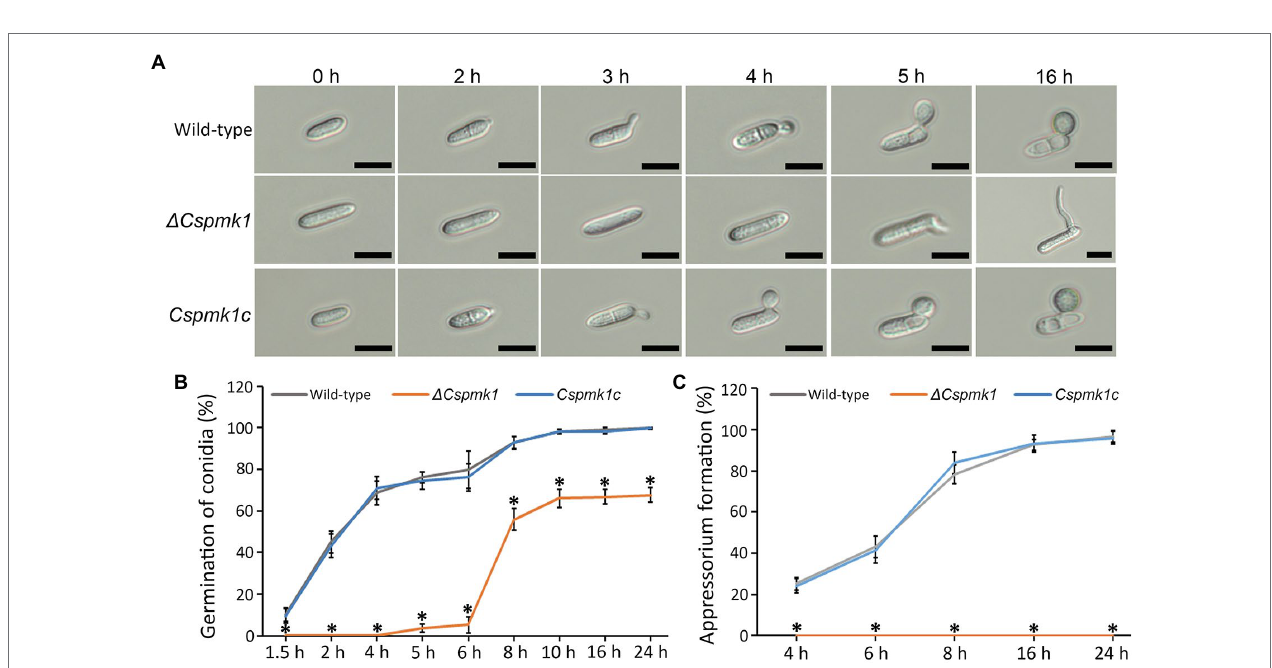
FIGURE 3 | CsPMK1 is essential for conidial germination and appressorium formation. (A) Photographs of conidial germination and appressorium formation. Conidial suspensions (5 × 10 4 ml − 1 ) harvested from 7-day-old oatmeal agar (OMA) were dropped into the hydrophobic surface of coverslips and incubated at 25 ° C. Scale bar, 10 μ m. (B,C) Quantitative measurement of conidial germination (B) and appressorium formation (C) . Conidial suspensions were placed on the hydrophobic surface of coverslips and incubated at 25 ° C. Significant differences in a group indicated with esthetic star ( * ) were estimated using Duncan’s test ( p <